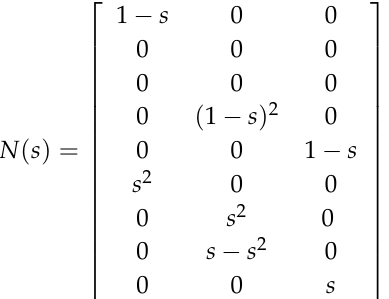
Table 1. Relative norm of TV 2 , relative norm of TX , norm of V T